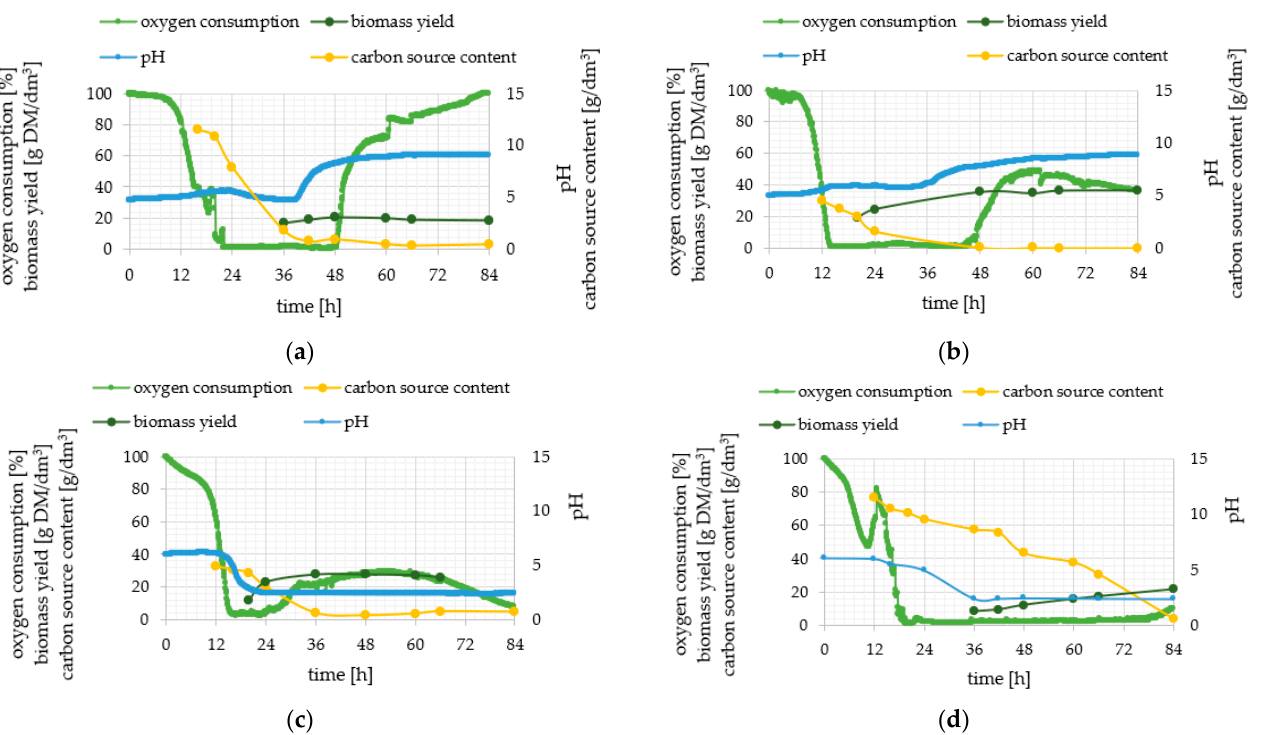
Figure 2. Changes in pH (thick light line), relative oxygen consumption (thick dark line), biomass yield (thin dark line) and carbon source content (thin light line; glucose or olive oil) during batch cultures of Y. lipolytica KKP 379 strain in YPG control ( a ), YPO control ( b ), MO5 ( c ) and MG8 ( d )